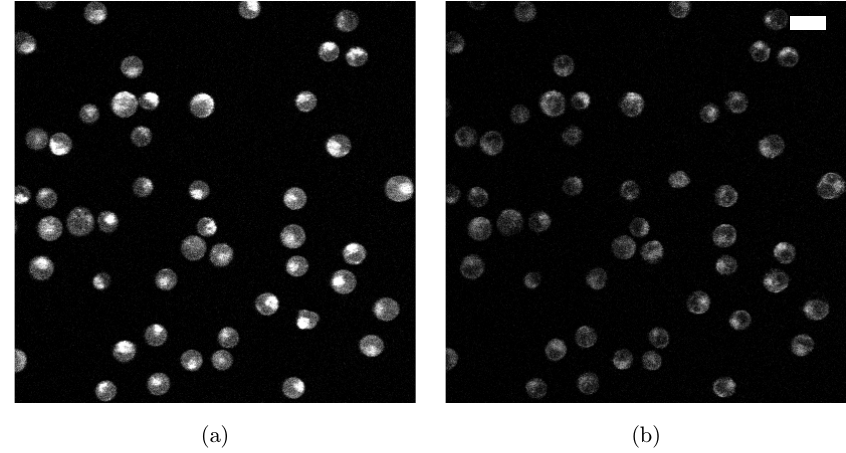
Fig. 2. In vitro mast cell degranulation process (a) image right after adding compound 48/80 and, (b) 20 min post adding compound 48/80. (Bar: 20 (cid:4) m).